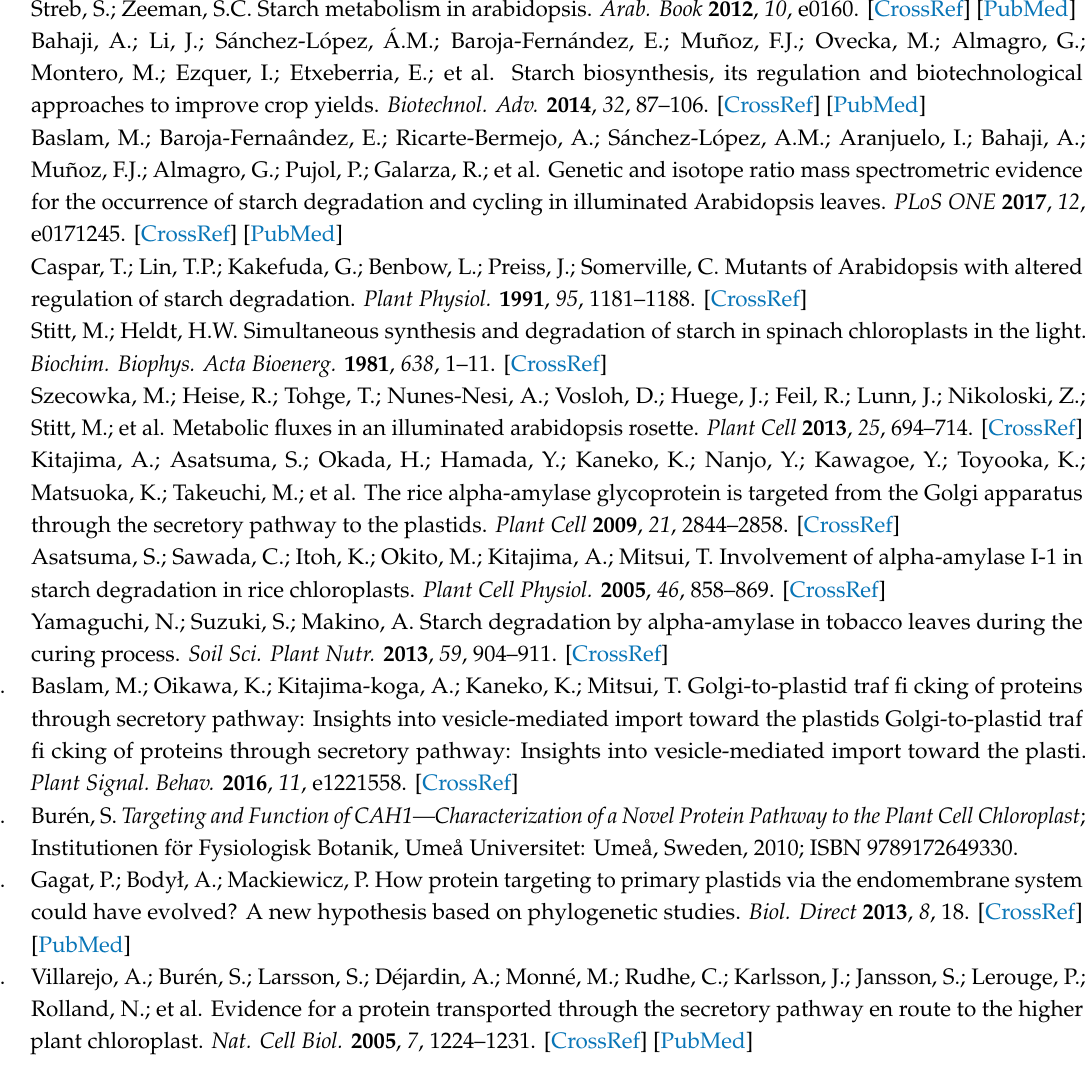
Figure S1: Amino acid sequence analysis of OsLACS9 proteins. Figure S2: Structural organization of OsLACS9. Figure S3: Localization of each truncated OsLACS9-GFP and WxTP-DsRed (plastid stroma marker) fusion protein co-bombarded in onion epidermal cells. Figure S4: Genetic information on rice lacs9-1 and